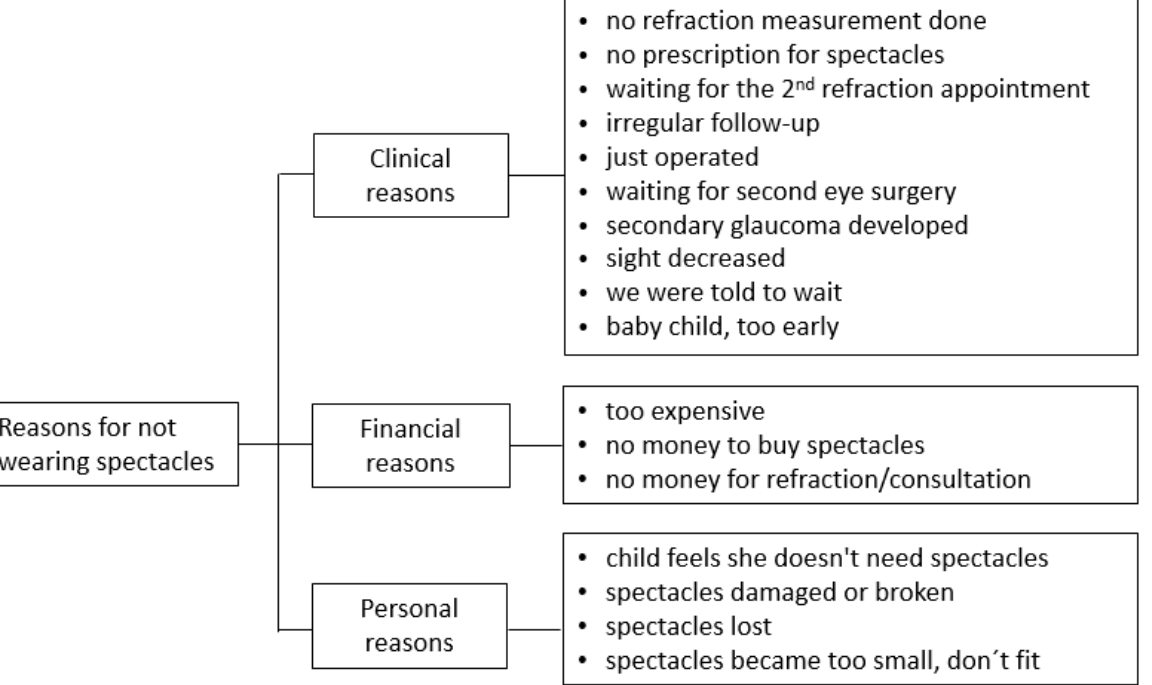
Figure 3. Reasons given by parents why their child did not wear eyeglasses. 3.3.4. Follow-Up Examination One third of parents (36%) had taken their child to the ophthalmologist, and the last visit was one or more years ago (Figure 4).